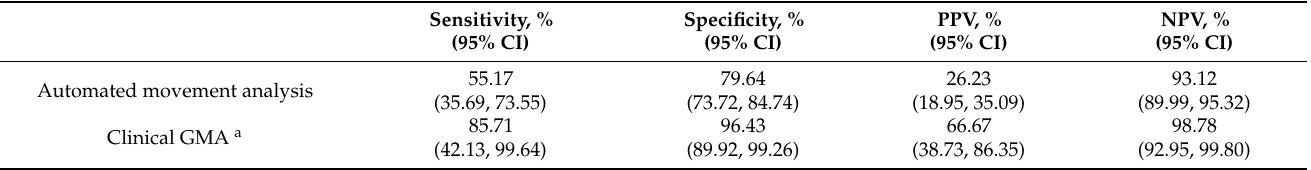
Table 3. Predictive value of multivariable logistic regression model for cerebral palsy.